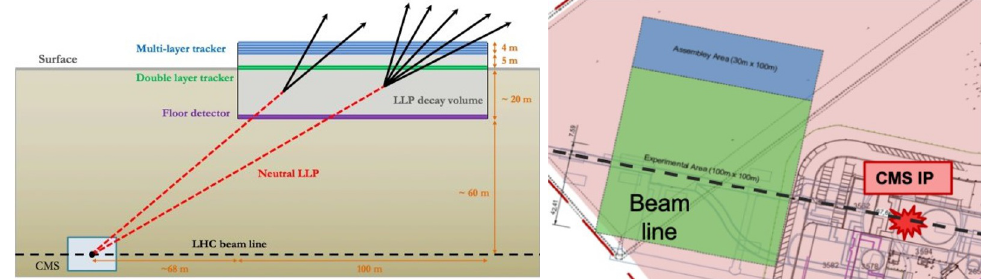
Figure 6 . MATHUSLA geometry: side (left) and top (right)